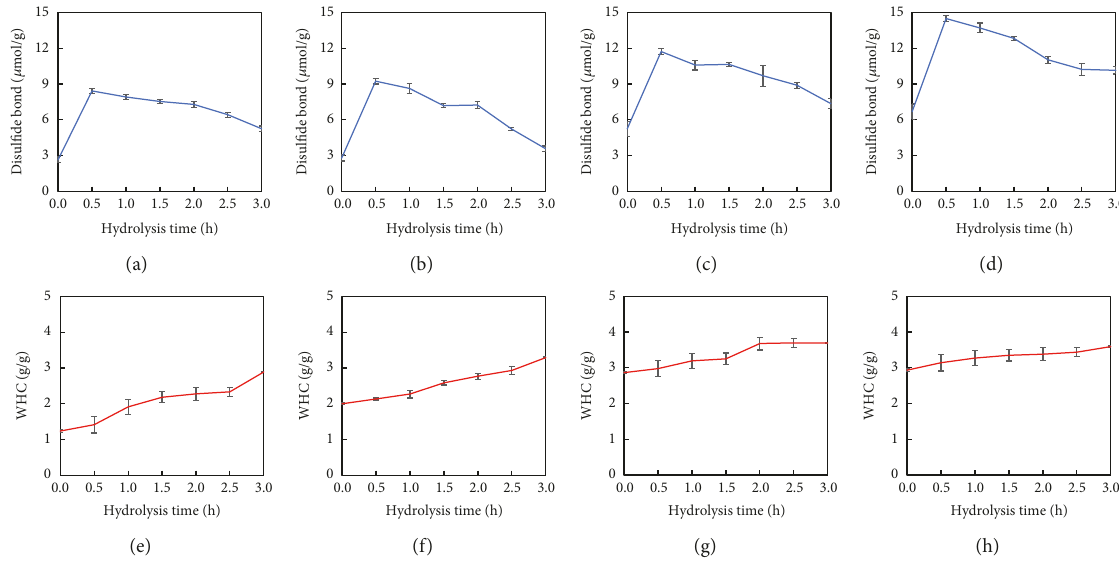
Figure 5: Disulfide bond of (a) nonextruded, (b) Ex60-HSPP, (c) Ex80-HSPP, and (d) Ex100-HSPP. WHC of (e) nonextruded, (f) Ex60-HSPP, (g) Ex80-HSPP, and (h)